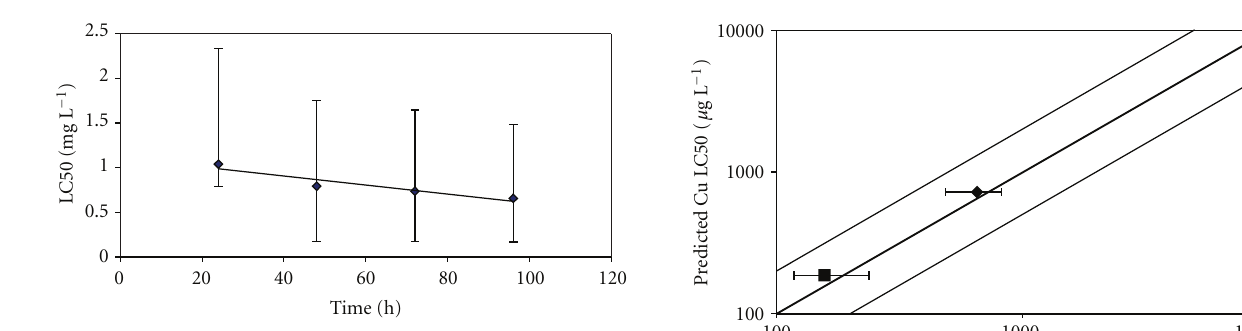
Figure 2: Cnesterodon decemmaculatus copper toxicity test: Cu LC50 values (mgL − 1 ) calculated by PROBIT analysis and confi- dence intervals (vertical bars) as a function of exposure time (h). Figure 3: Measured copper toxicity (LC50, in µ g L − 1 ) to C. decemmaculatus by Villar et al. (closed square) and the present study (closed diamond) compared with predicted copper toxicity using the BLM developed for P. promelas . The thicker line represents a 1:1 relationship. The thinner line represents predictions within a factor of 2. The error bars represent 95% confidence intervals.